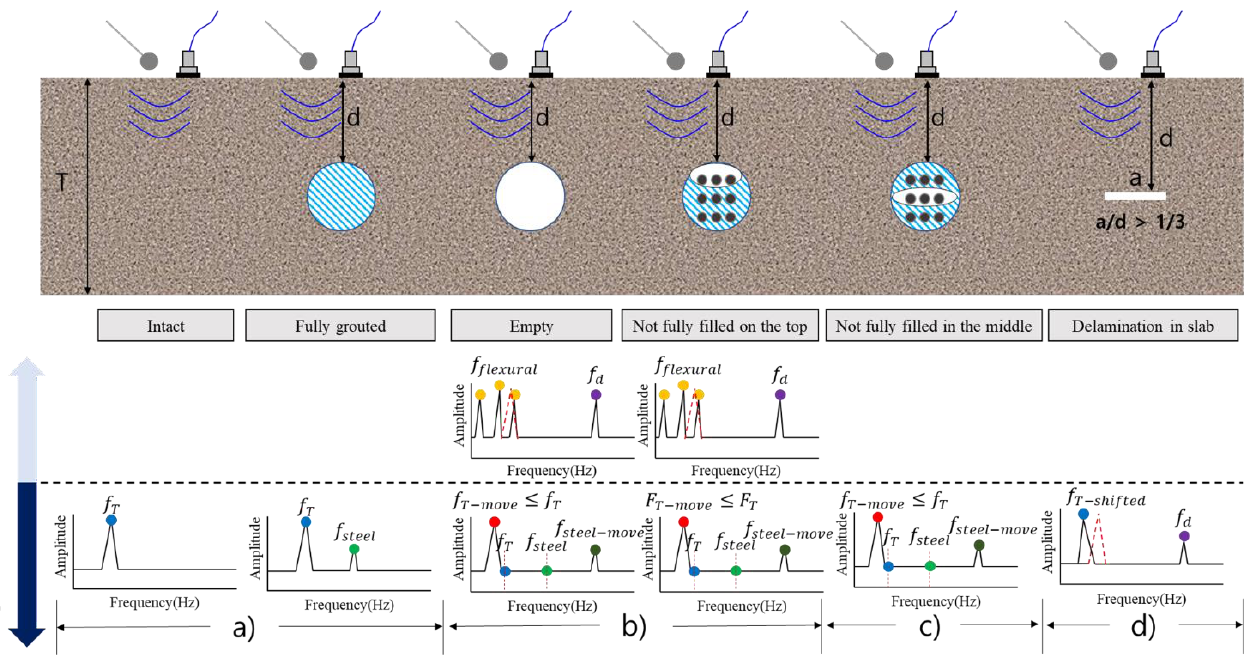
Figure 12. Six types tested and expected spectra in this study.